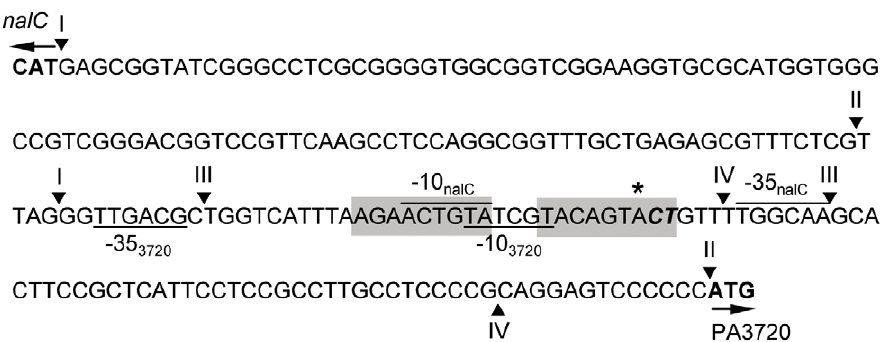
Figure 4. Mapping the PA3720- armR transcriptional start site. The nalC /PA3720- armR intergenic region highlighting the RACE-determined transcription start site for PA3720- armR (bolded and italicized), the predicted transcriptional initiation site (marked with an asterisk; assessed using neural network promoter prediction software provided by M. G. Reese at http://www.fruitfly.org/seq_tools/promoter.html ), the nalC and PA3720 start codons (arrows), and putative 2 10/ 2 35 sites for nalC (overlined) and PA3720- armR (underlined) promoters. The end-points of PCR-generated PA3720-distal (I) and -proximal (II) fragments and oligonucleotides (III and IV) used in EMSAs with purified NalC (see Fig. 2B) are identified by arrowheads above the sequence. The shaded sequence corresponds to an inverted repeat and possible NalC-binding site.